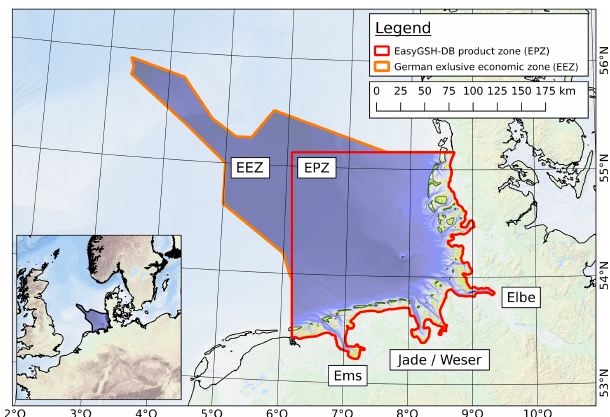
Figure 1. Spatial extent of the German Bight with EasyGSH-DB’s product zone (EPZ) and larger German Exclusive Economic Zone (EEZ) within the North Sea with a bathymetric model of 1996. Po- sitions of major estuaries given for